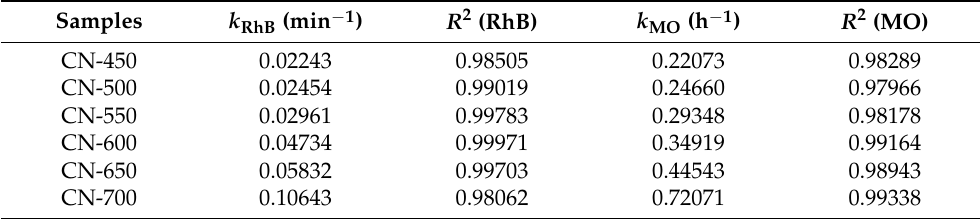
Figure 11. Photocatalytic activities of RhB ( a ) and MO ( b ) under visible light; corresponding kinetic curves of RhB ( c ) and MO ( d ) for all samples; recycling runs in the photodegradation of RhB ( e ) and MO ( f ). Table 4. Kinetic rate constants of